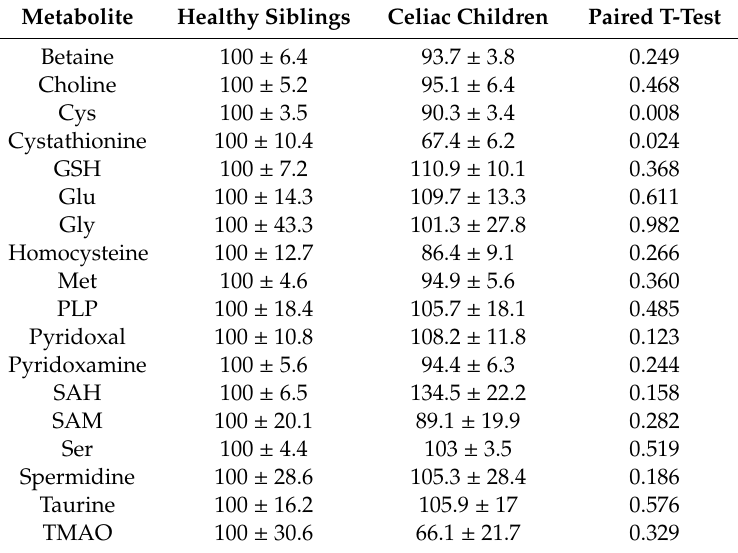
Table 5. Plasma metabolite variations in healthy siblings and celiac